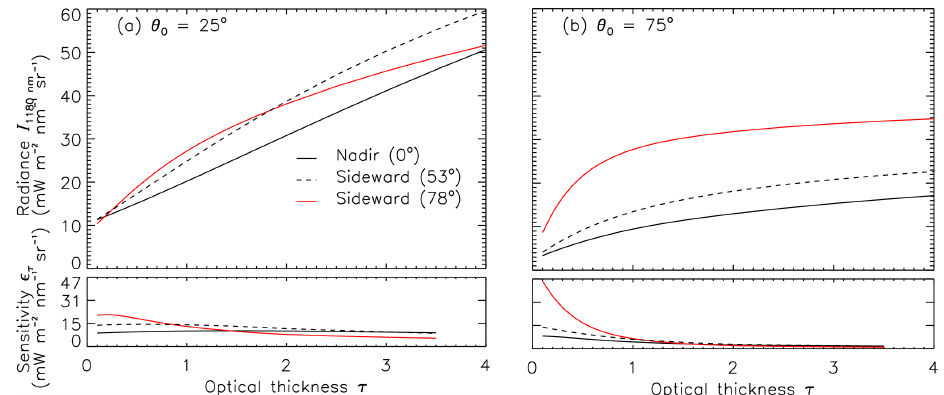
Figure 3. Simulated radiance I RT , 1180 for three different sensor orientations as a function of cirrus optical thickness τ . Results for solar zenith angles of θ 0 = 25 ◦ (a) and θ 0 = 75 ◦ (b) are displayed. The sensitivity ε τ is given in the lower